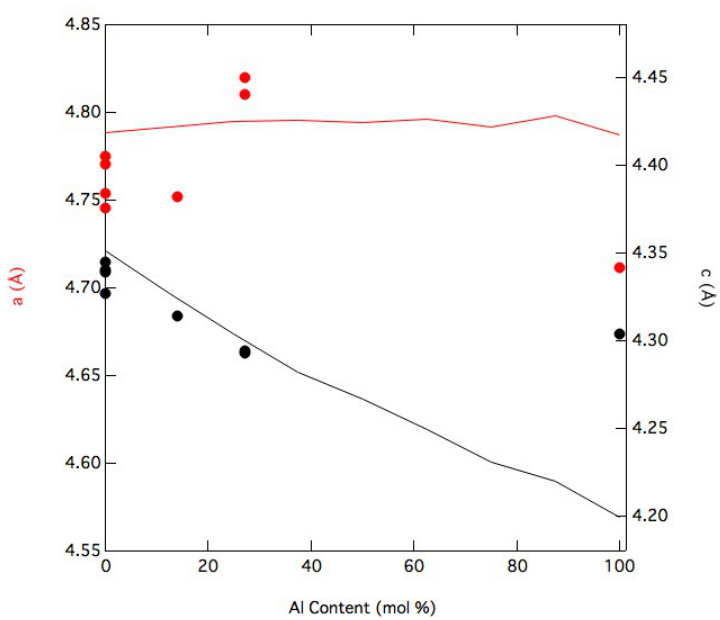
Figure 2. Zero-pressure lattice constants a (red; left) and c (black; right) as a function of aluminum content. Lattice constants as reported in synthesis experiments [1,3,10,12,15,22,23] (circles) are plotted for comparison. Table 1. Zero-pressure, static, unit-cell volume, and lattice constants as a function of composition for ensemble-averages of each parameter calculated at 1500 K, compared to a selection of synthesis and comparable computational